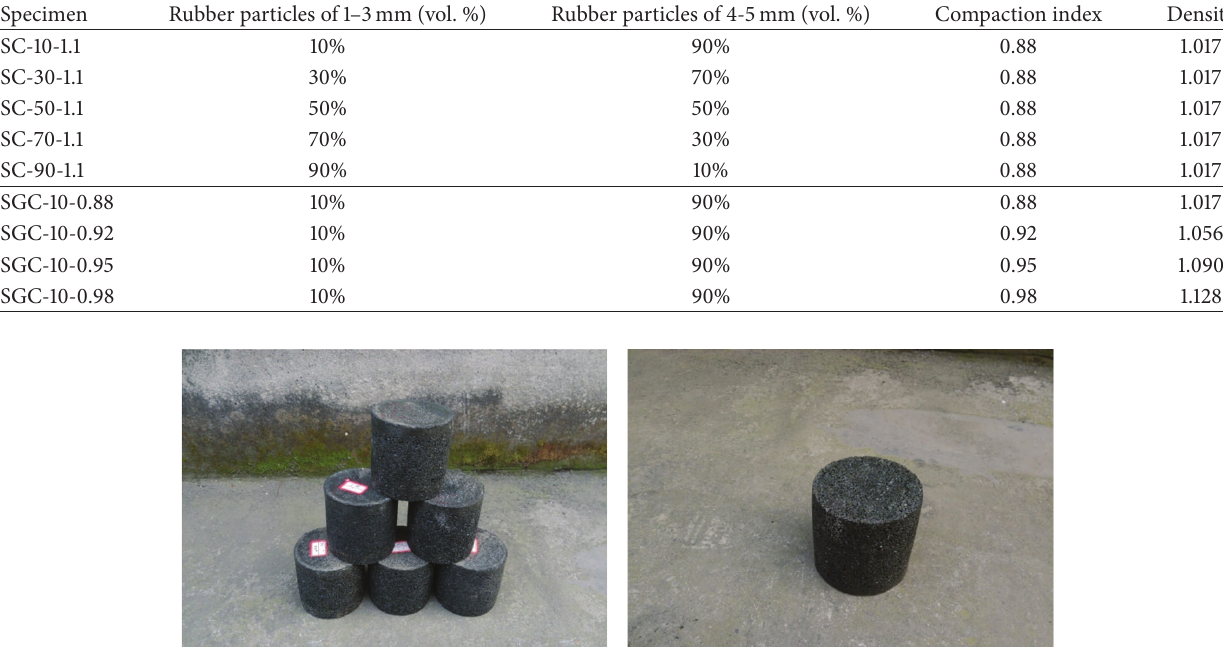
Table 3: Mix proportion.